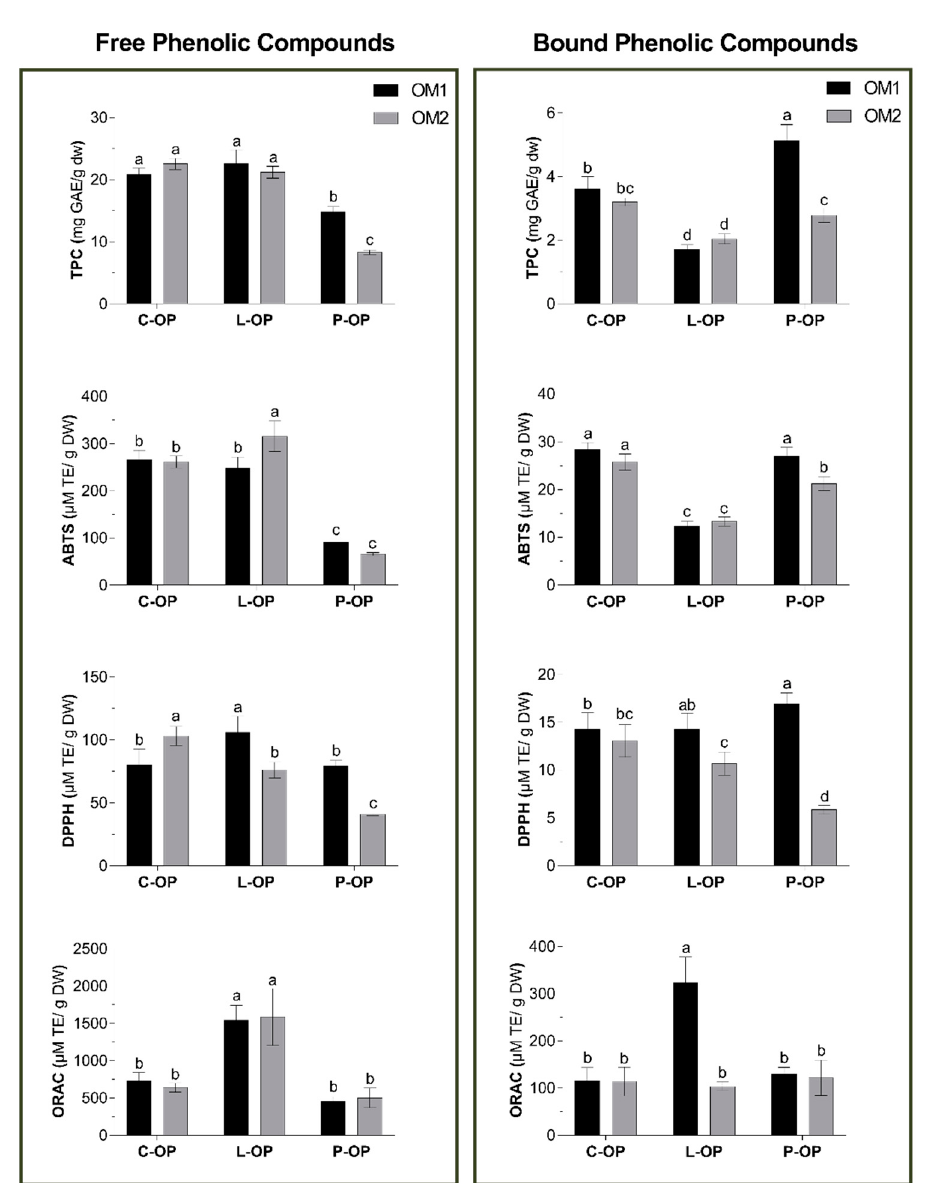
Figure 3. Content of total, free and bound phenolic compounds and antioxidant activity using DPPH, ABTS and ORAC methods from crude olive pomace (C-OP), the liquid-rich fraction (L-OP) and pulp- rich fraction from olive pomace (P-OP). Data were expressed as mean ± SD (n = 3). The different superscripts in the same column were significantly different ( p < 0.05). Abbreviations: OM 1—olive mill 1, OM 2—olive mill 2, C-OP—crude olive pomace, L-OP—liquid-rich fraction, P-OP—pulp-rich fraction. GAE—Gallic acid equivalents, TE—Trolox equivalents.